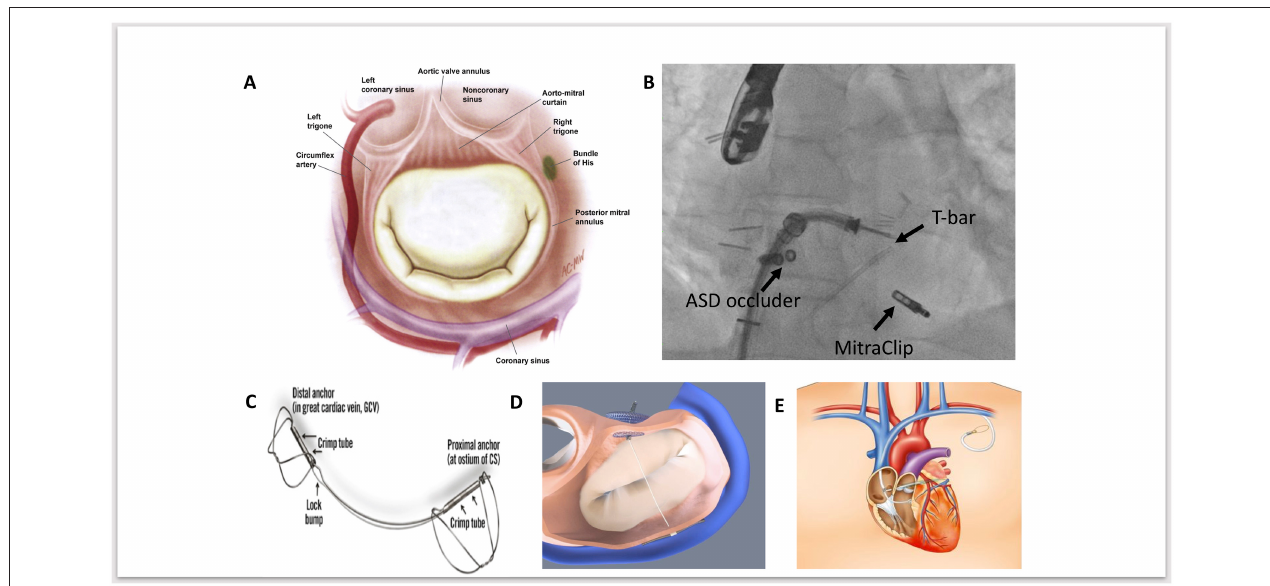
FIGURE 1 | (A) Anatomical relationships of the mitral valve, demonstrating the close proximity of the mitral annulus, coronary sinus, circumflex artery and conduction system. Adapted and reprinted from Carpentier’s Reconstructive Valve Surgery with permission from Elsevier. (B) Fluoroscopic image of MitraClip implantation as a second procedure, following a previous ARTO device; fluoroscopic landmarks for this are the Atrial Septal Defect (ASD) occluder device and the T-Bar. (C) The Carillon coronary sinus implant (Cardiac Dimensions) device. Adapted and reprinted from Eurointervention, Natarajan et al, The big parade: emerging percutaneous mitral and tricuspid valve devices, 2017, with permission from Europa Digital & Publishing. (D) Graphical image of the ARTO (MVRx Inc) device following deployment, with two anchors either side of the tether. In this image projection, the T-bar anchor sits inferiorly and the atrial septal anchor (occluder device) sits superiorly. Adapted and reprinted from Eurointervention, Natarajan et al, The big parade: emerging percutaneous mitral and tricuspid valve devices, 2017, with permission from Europa Digital & Publishing. (E) Graphical image demonstrating the anatomical course of cerclage annuloplasty to reduce mitral annular dimensions. Adapted and reprinted